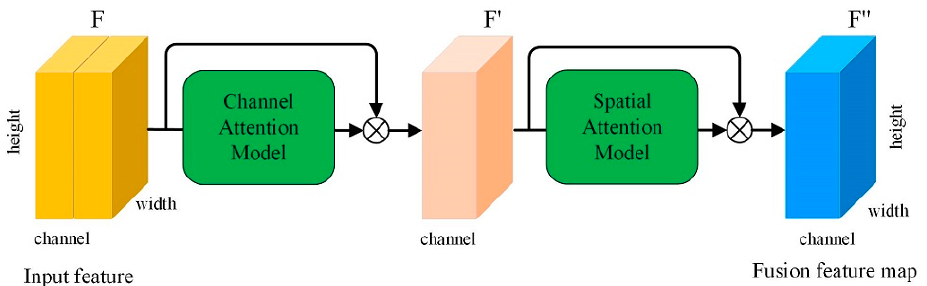
Figure 3. Structure illustration of the channel and spatial attention